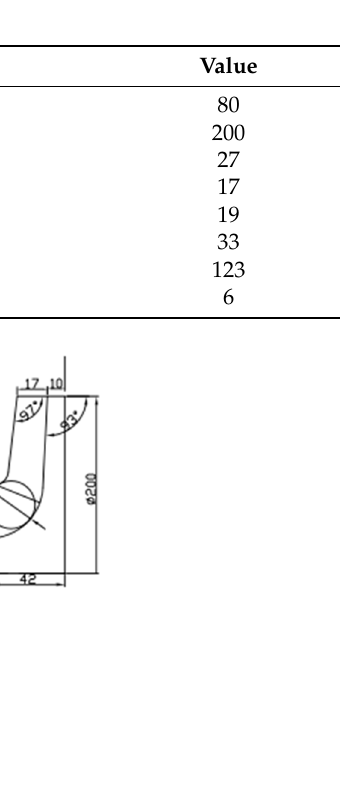
Figure 1. 2D sketch of the original impeller.